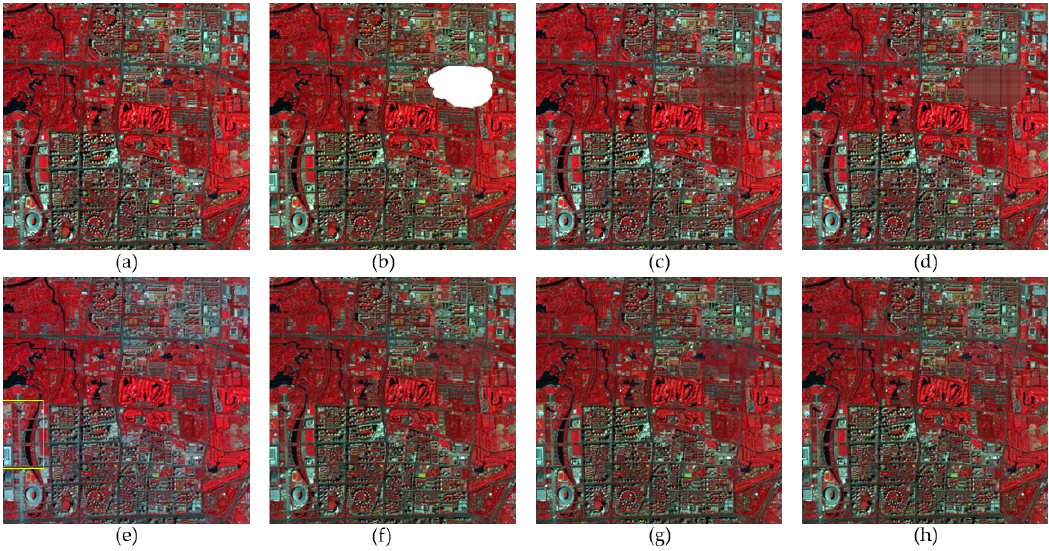
Figure 10. SPOT-5 images for the second simulated experiment: ( a ) original clean image; ( b ) simulated cloud image; ( c )–( h ) the results of FaLRTC, HaLRTC, TRPCA, TVLRSDC, TOS, and TSSTO, respectively.